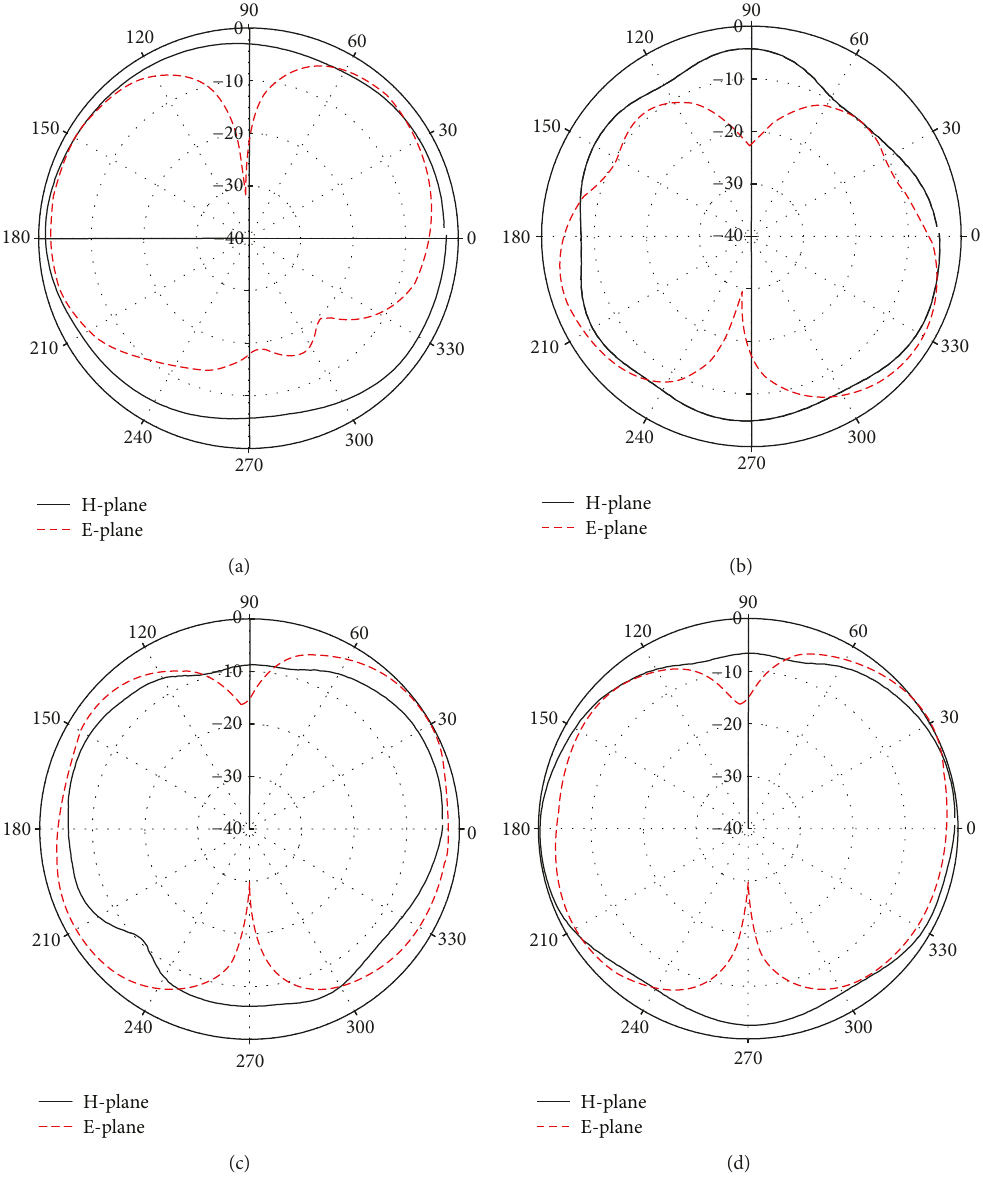
Figure 6: Measured radiation pattern of the proposed antenna. (a) 3.26GHz. (b) 3.77GHz. (c) 4.41GHz. (d)